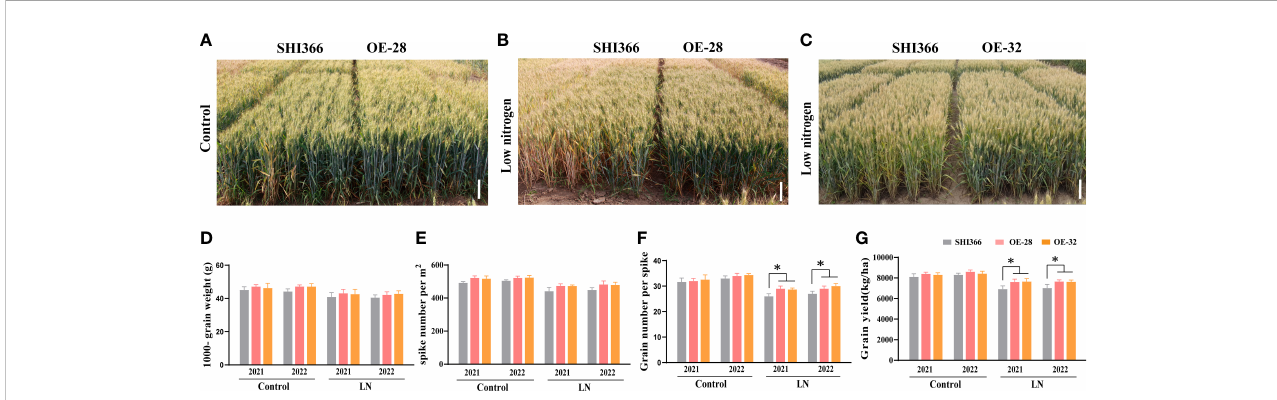
FIGURE 3 Low nitrogen stress tolerance analysis of EdVP1 transgenic wheat grown in the fi eld Phenotypes of OE-28 and SHI366 wheat plants grown under (A) normal and (B) low nitrogen conditions in 2022. (C) Phenotypes of OE-32 and SHI366 wheat plants grown under low nitrogen conditions in 2021. Scale bars = 10 cm (D) The 1000-grain weight, (E) spike number per m 2 , (F) grain number per spike, and (G) grain yield of the OE-28 and OE-32- overexpressing lines and wild-type SHI366 plants grown under normal and low nitrogen conditions in 2021 and 2022. Data represent the mean of values from three biological replicates ± standard deviation. Asterisks indicate signi fi cant differences between the OE-28, OE-32, and SHI366 wheat plants, as assessed using Duncan ’ s multiple range test (* p < 0.05, Duncan ’ s multiple range test).